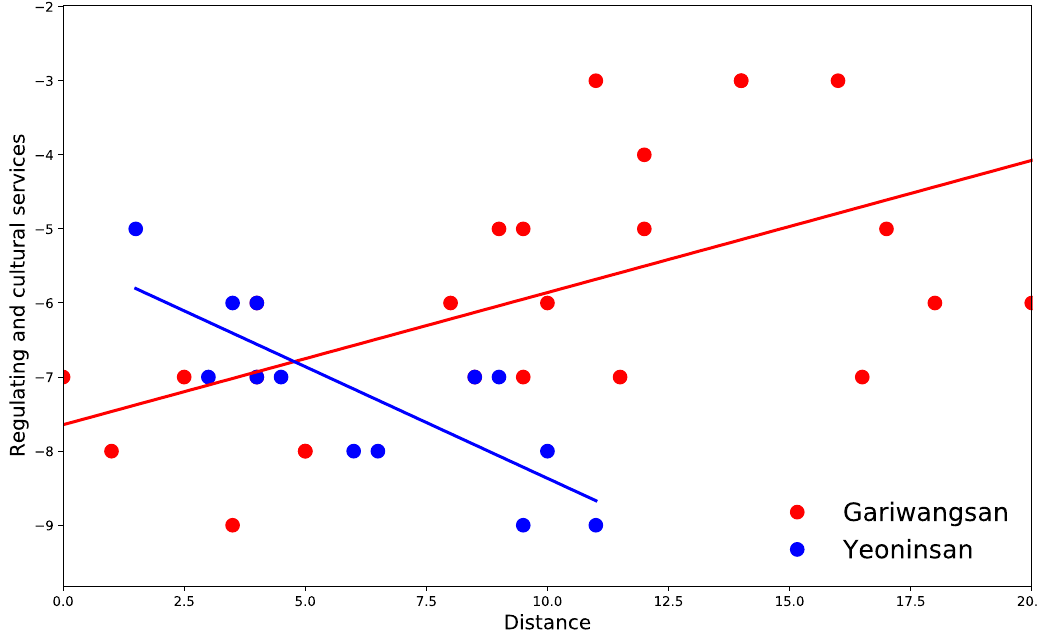
Figure 5. Relationship of regulating and cultural ES categories in Gariwangsan and Yeoninsan.